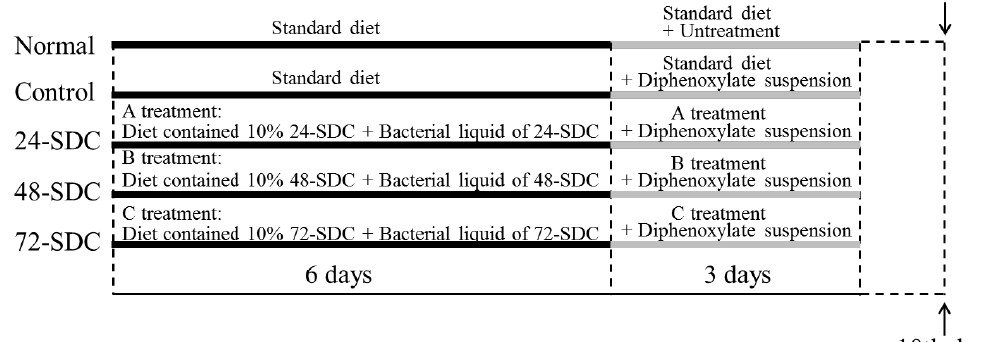
Figure 1. Schematic of the experimental procedure. 24-SDC: 24-h-fermented Shuidouchi; 48-SDC: 48-h-fermented Shuidouchi; 72-SDC: 72-h-fermented Shuidouchi.